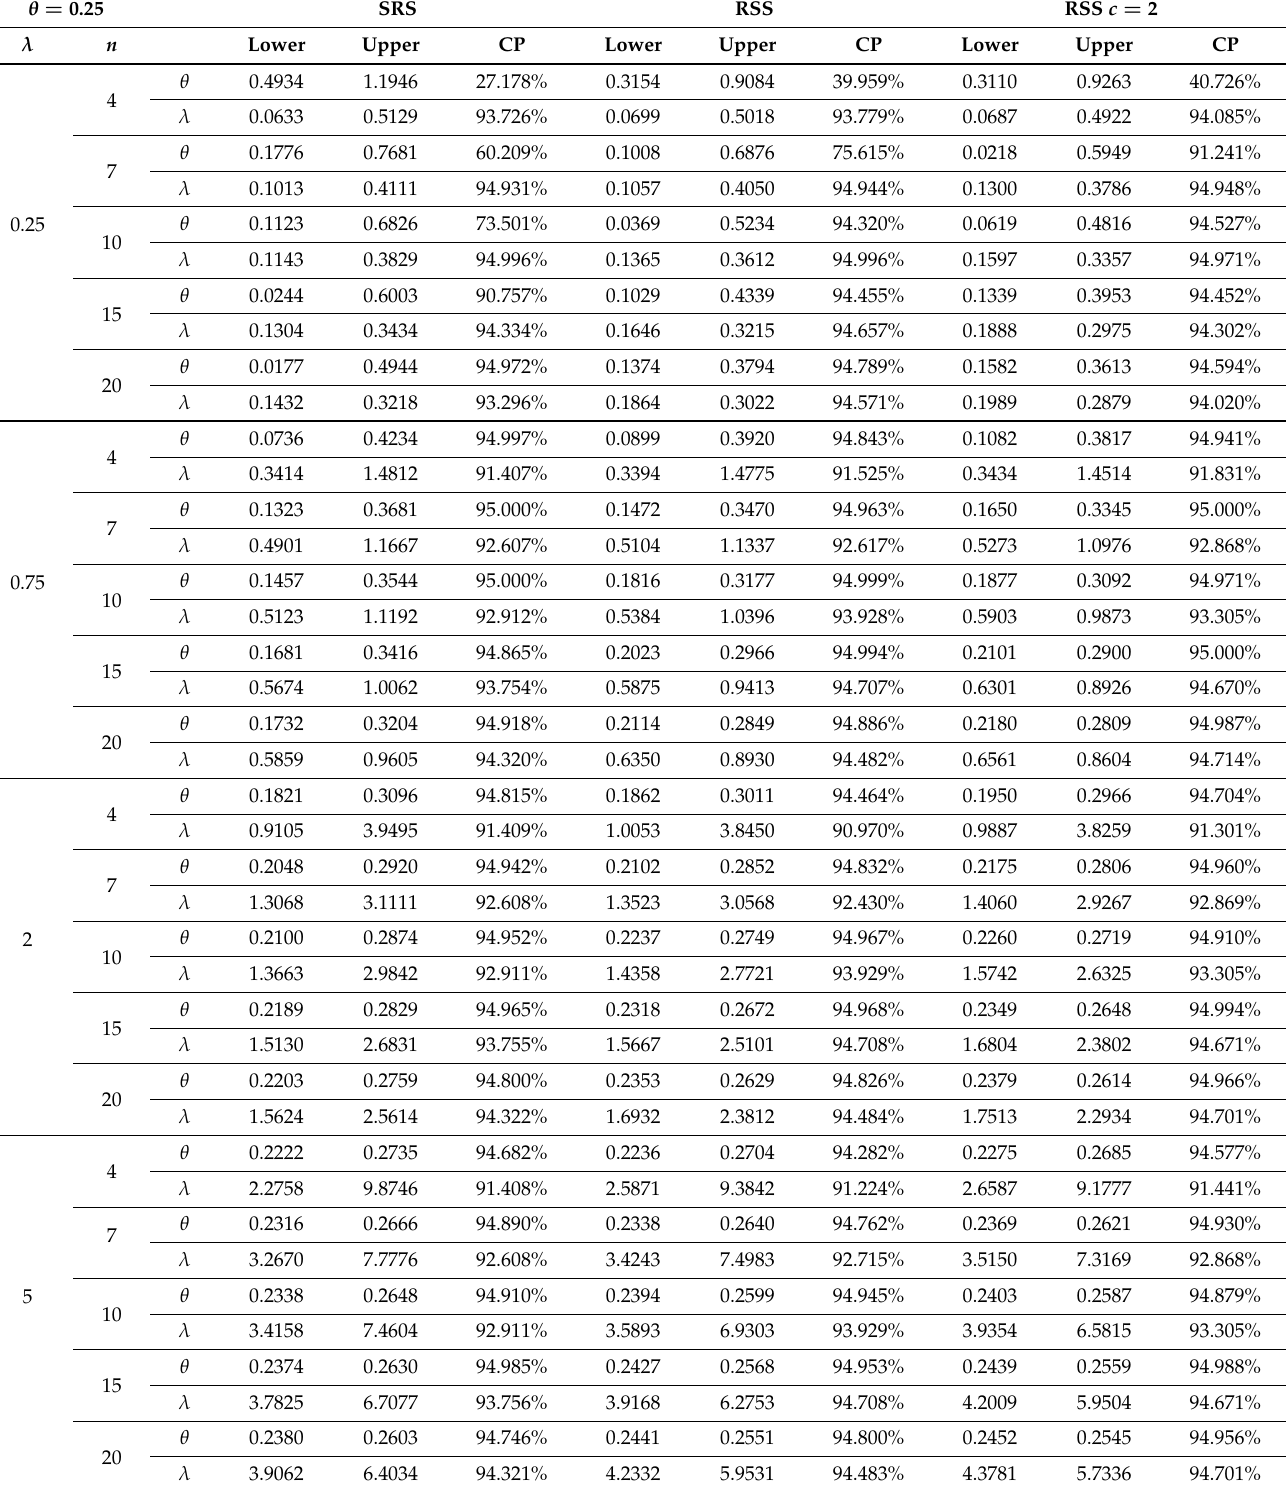
Table 6. Lower, upper bounds of CI and CP for the GB( θ , λ ) distribution under the SRS and RSS schemes when θ =